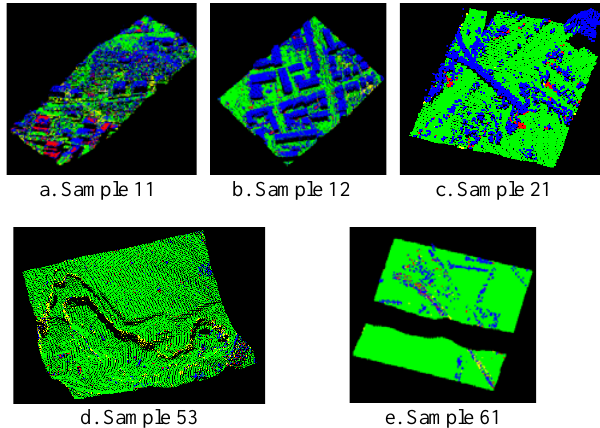
Figure 8. Labeled point clouds on five ISPRS testing samples (Green: correctly labeled of ground, Blue: correctly labeled of non-ground, Yellow: ground misclassified as non-ground, and Red: non-ground misclassified as